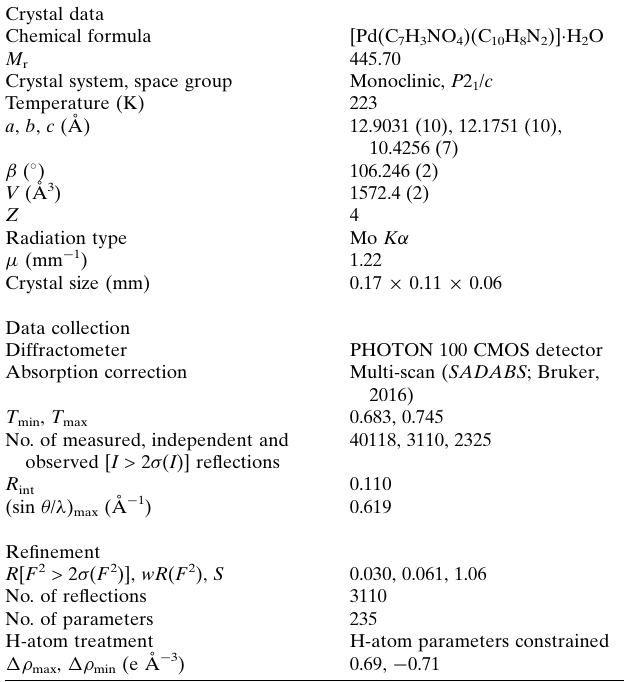
Table 2 Experimental details.